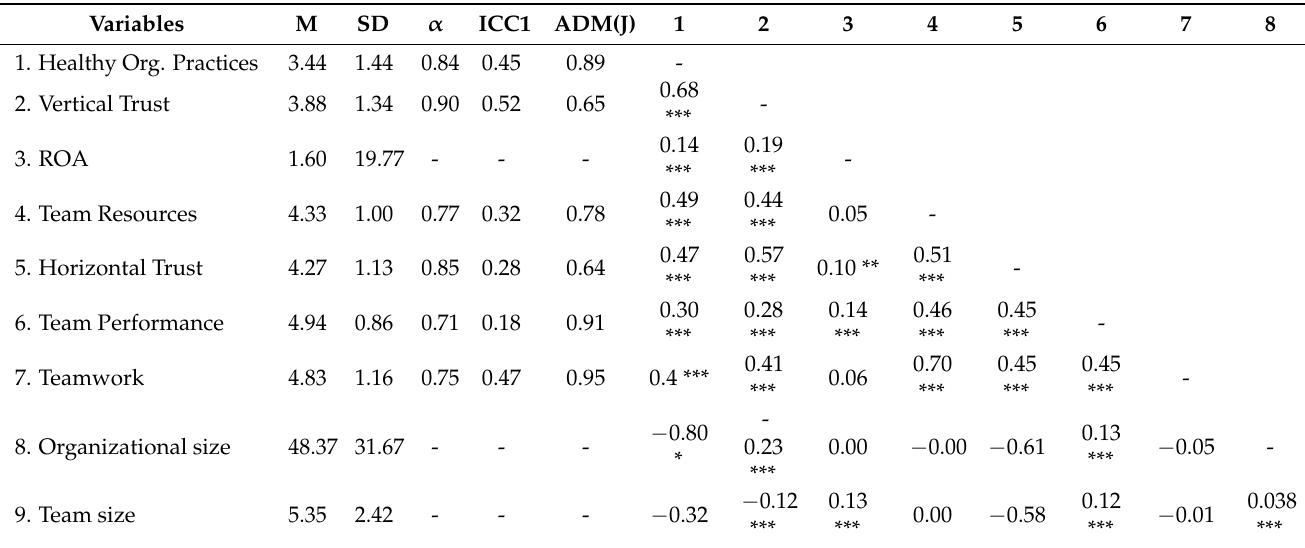
Table 1. Means, standard deviations, aggregation indices, and intercorrelations among the study variables at the individual level (N = 890).